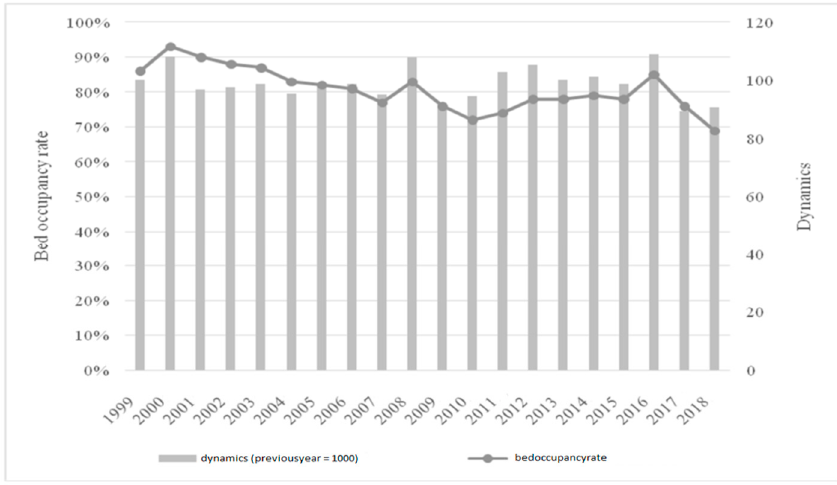
Figure 3. Bed occupancy in the analyzed hospital in 1999–2018. Table 3. Bed occupancy rate in the analyzed institution and in Poland in Statistics for the analyzed institution show that bed occupancy varied in the analyzed period from 69% in 2018 to 93% in 2000. After 2000, bed occupancy gradually decreased and reached the minimum in 2010 (72%). There was a very clear correlation between the number of beds and their occupancy (Pearson’s correlation coefficient at the level of 0.788 for the period 1999–2010). The level of both indicators gradually decreased, which indi- cates that the demand for healthcare services was falling. Thus, despite the decreasing